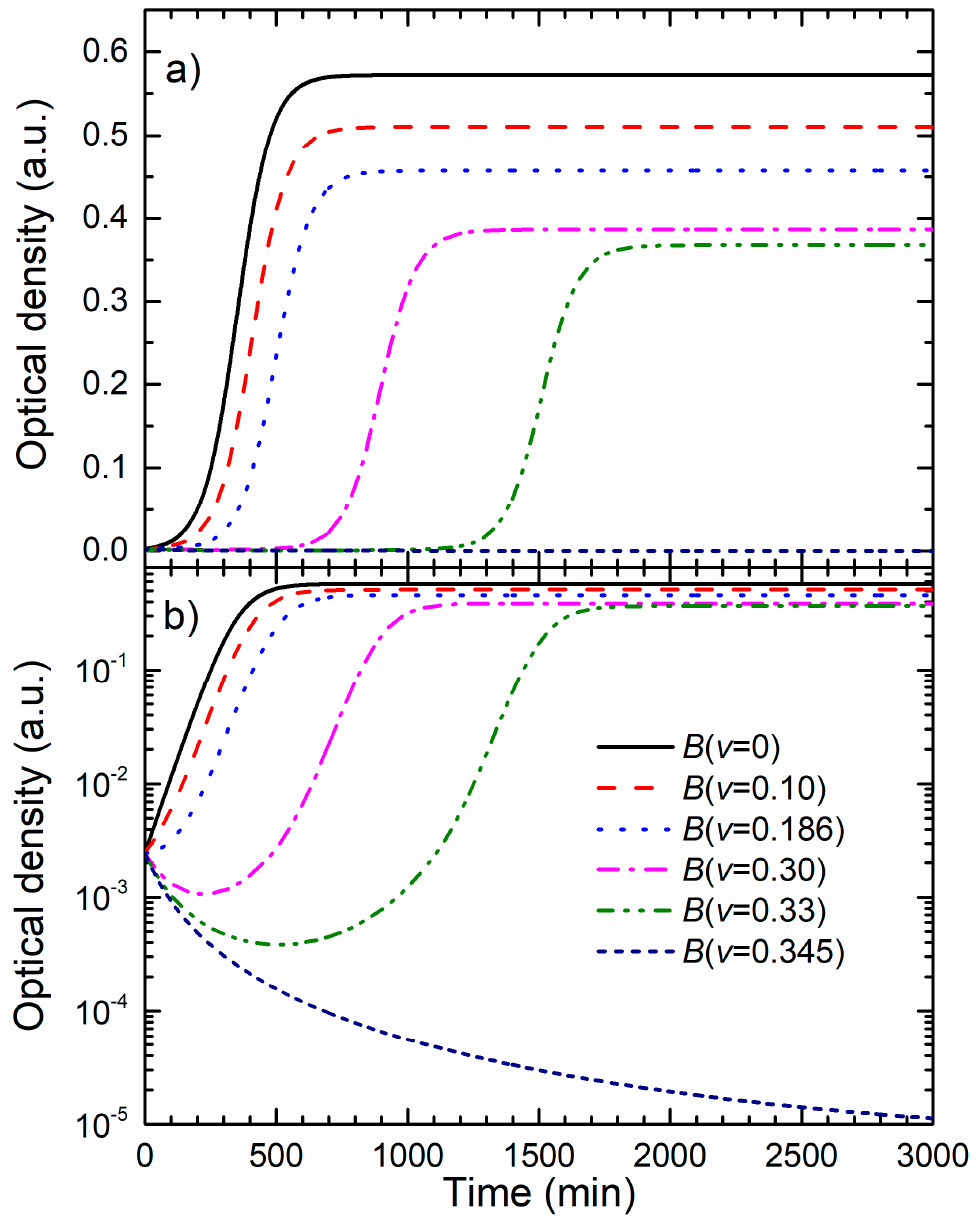
Figure 5. ( a ) Bacterial population obtained from solutions of Equations (1)–(3) for β = 0 for different colloid volume shares v . The increase of the colloid volume share reduces the maximal bacterial concentration and postpones the exponential bacterial growth. ( b ) The same data given in logarithmic scale, exhibiting the population dynamic of the lag phase.